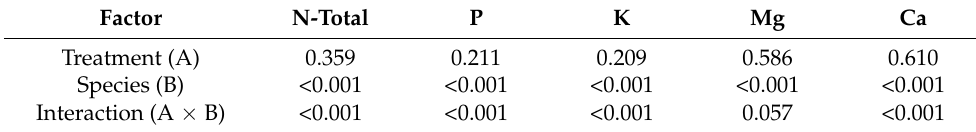
Figure 3. Effect of biostimulants on the mineral composition of herbage in the analyzed herb species: a–h—various letters denote significant differences at p < 0.05 (Tukey’s test); CA—application of Calleaf Aminovital; MAP—application of Maximus Amino Protect. Table 3. p -Value for ANOVA on the mineral composition of herbage in the analyzed herb